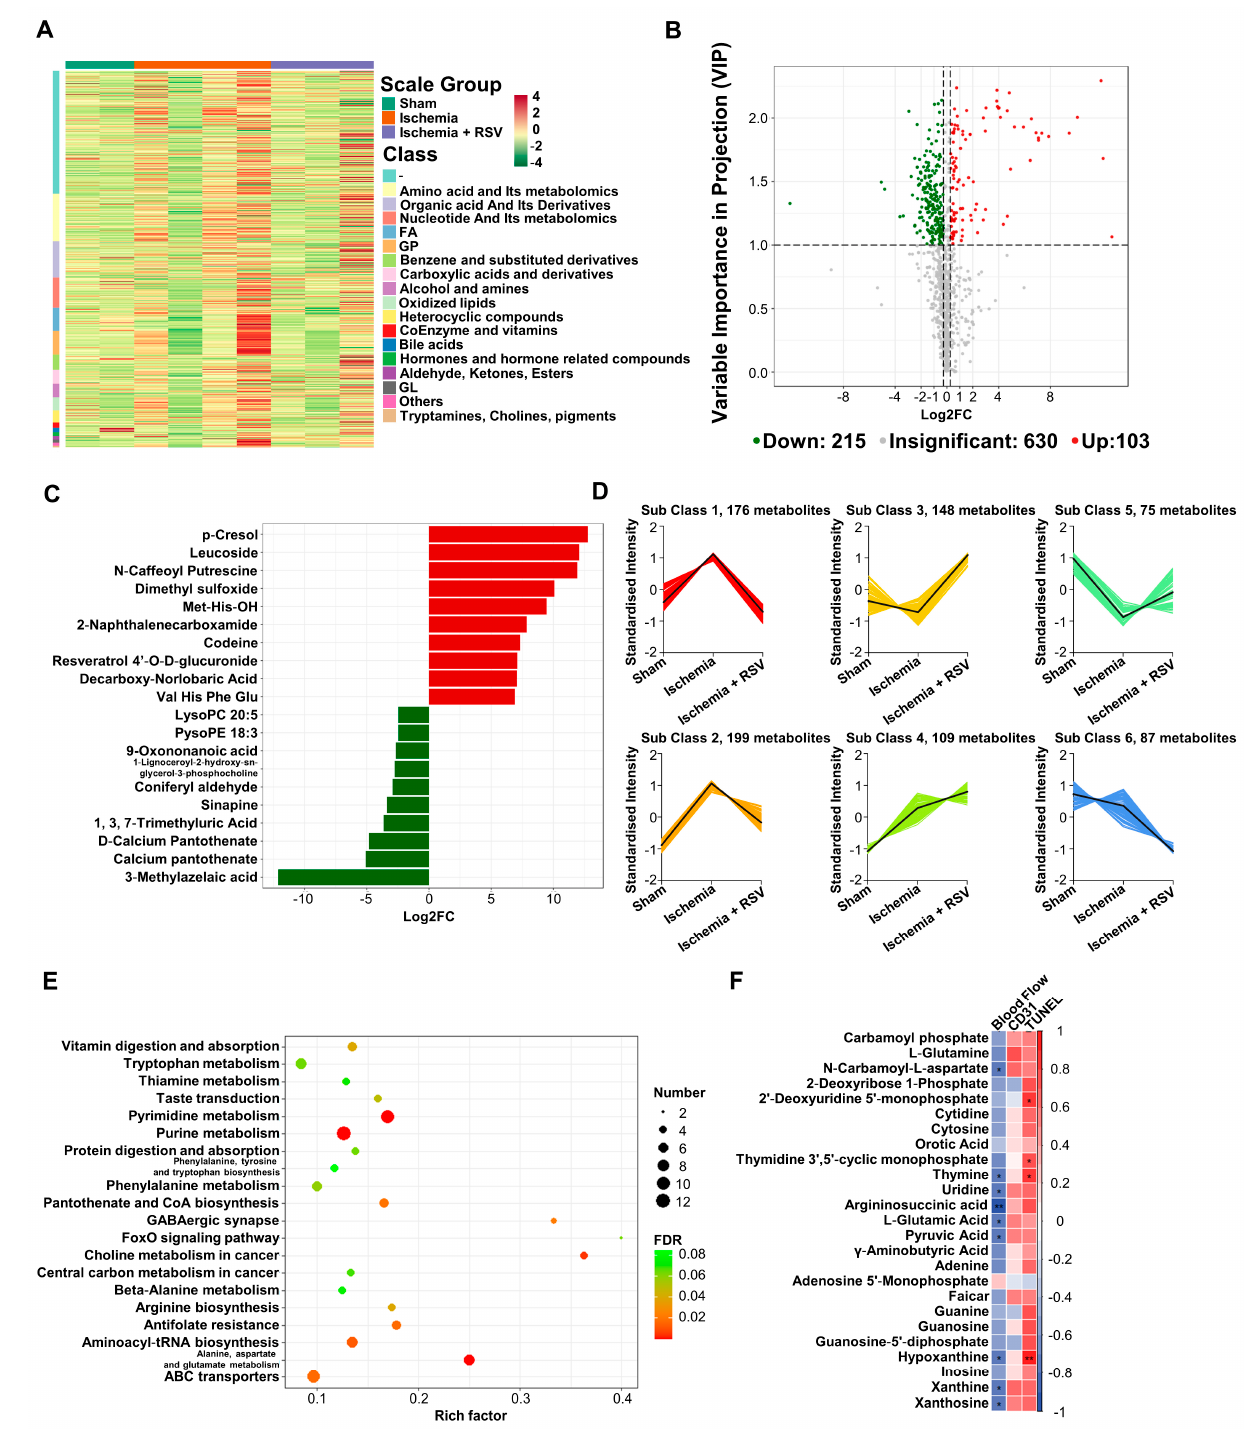
Figure 4. The metabolomic analysis of the gastrocnemius muscles. ( A ) Heat map was performed to show the metabolites of all experimental groups. The row clustering tree represents a metabolite clustering and each column represents sample replication. Normalized signal intensities of metabolites (unit variance scaling) are visualized as color spectrum: red and green represent high and low level of metabolites, respectively. ( B ) Volcano plot showed the differentially expressed metabolites of the ischemia + RSV group against the ischemia group. Red dots indicate up-regulated metabolites and green dots indicate down-regulated metabolites (Fold change (FC) > 1.2, VIP > 1). ( C ) Bar plot displayed the top 10 up-regulated and down-regulated metabolites (FC > 1.2). ( D ) The K-means was conducted to cluster the metabolites into 6 cluster groups. X -axis represents the experimental groups and Y -axis represents the relative level of metabolites. ( E ) KEGG en- richment pathway analysis showed the metabolic pathway enriched by the screened metabolites. The bubble size repre- sents the differential metabolites number in each pathway. The bubble color shows the FDR value of each pathway. The